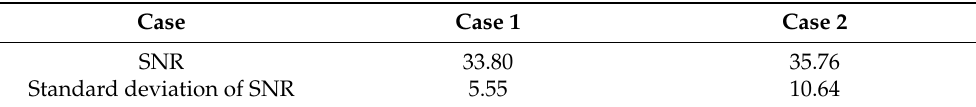
Figure 6. 13 C MR Spectra of the corn-oil phantom using 2D CSI sequence. 1 H reference image was acquired using high- performance 1 H RF coil with FIESTA cine sequence: ( a ). Each 13 C MR spectra of the corn-oil phantom was acquired using 16-leg low-pass PFT 13 C birdcage RF coil with 40 CPSCs: ( b ) and 16-leg low-pass 13 C birdcage RF coil without CPSCs: ( c ). For the SNR comparison between ( b , c ), a total of 27 13 C spectral grids were selected, which are indicated by the red broken line in ( a ). The overall SNR at the selected 13 C spectral grid of the corn-oil phantom in ( b , c ) was 33.80 and 35.76, respectively. There was a slight SNR drop of 5.5% at the selected 13 C spectral grid in ( b ) compared with ( c ). Table 4. SNR and standard deviation of 13 C spectral grid in the corn-oil phantom. There was a 5.5% drop of overall SNR around the corn-oil phantom. This result can verify that the noise added by 40 CPSCs can be negligible.